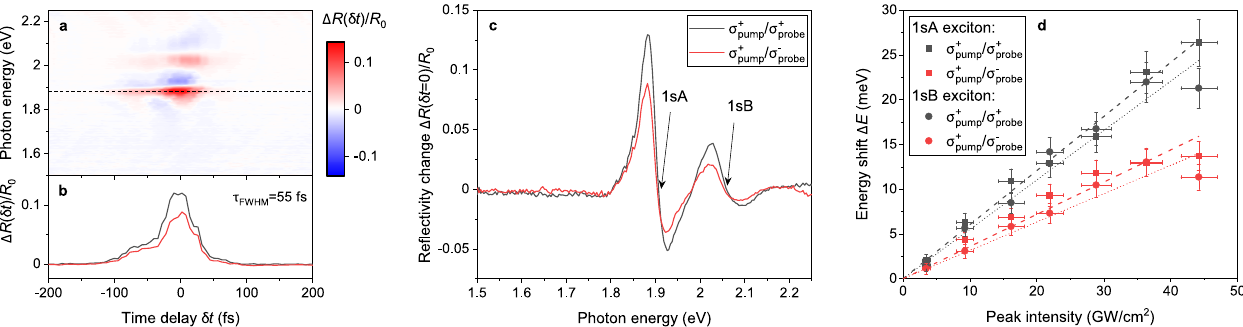
Fig. 3 Transient re fl ectivity spectra of MoS 2 monolayer. a Transient re fl ectivity spectra of MoS 2 monolayer Δ R ( ℏ ω , δ t )/ R 0 ( ℏ ω ) as a function of the time delay between the pump (photon energy of 0.62 eV) and broadband probe pulses both of the same circular polarization handedness. b Pro fi le of the signal in time-domain for the same (black curve) and opposite (red curve) circular polarization handedness of the pump and probe pulses. c Transient re fl ectivity spectrum at zero time delay for peak intensity of the pump pulse of 36 GW/cm 2 . d Maximum energy shifts obtained from the measured spectra at zero time delay as a function of the peak intensity of the pump pulse for 1sA and 1sB excitonic resonances. Black/red dashed and dotted curves represent the linear fi tting of the OS/BS shifts of 1sA and 1sB excitons, respectively.